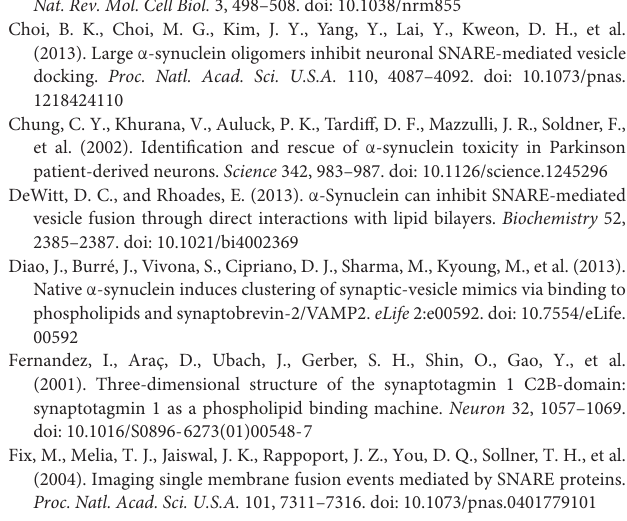
FIGURE S1 | Two round gel filtration of α S. (A) Chromatogram from the 1st round of gel filtration. After one round of gel filtration, α S elutes as two overlapping peaks between fractions 7–14. The UV absorbance value has been normalized with respect to the maximum peak intensity. (B) SDS-PAGE gel after the 1st round of gel filtration. The fraction numbers indicated on the SDS-PAGE correspond to the fractions shown in part (A) . Fractions 7–10 display a high molecular weight bands which correlates to the first peak in the chromatogram. Fractions 11–14, indicated by arrows, were combined, concentrated, and subjected to another round of gel filtration. (C) Chromatogram from the 2nd round of gel filtration. After two rounds of gel filtration, α S elutes as a single peak between fractions 10–14. (D) SDS-PAGE of the 2nd round of gel filtration. Fractions 12–14 display a molecular weight bands consistent with α S which correlates to the single peak in the chromatogram. A conservative approach was used and fractions containing an arrow underneath were combined, concentrated and used for TIRF experiments. FIGURE S2 | SDS-PAGE of purified α S before and after storage at − 80 ◦ C. (A) SDS-PAGE gel of α S immediately after two rounds of gel filtration before storing at − 80 ◦ C. (B) SDS-PAGE gel of the same α S after 2 weeks of storage at − 80 ◦